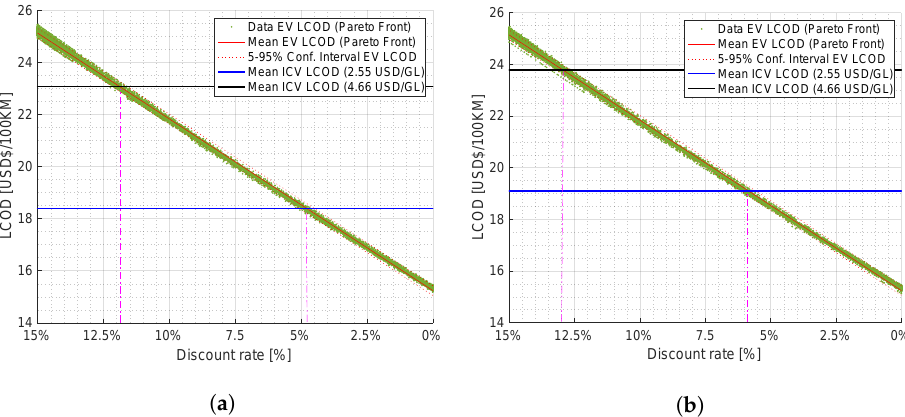
Figure 5. Sensibility Analysis with respect to EV the Discount rate. ( a ) Case A ( r = 10%). ( b ) Case B ( r =